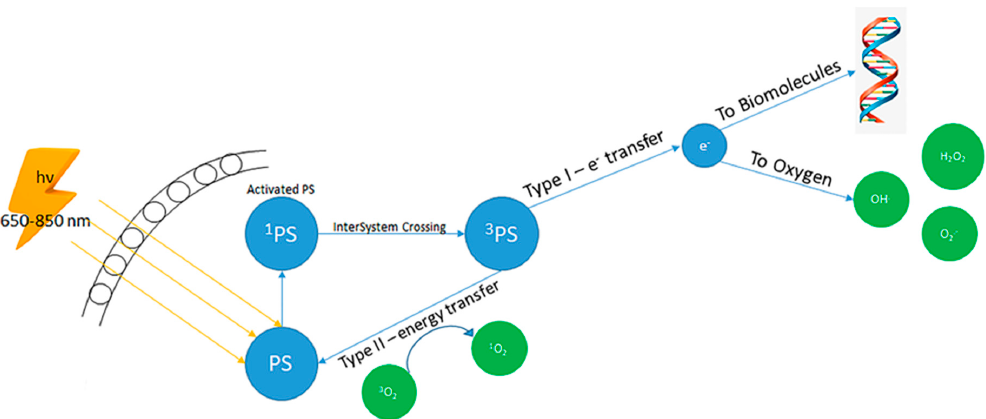
Figure 2. Mechanisms of photodynamic therapy. When a photosensitiser (PS) absorbs a photon, it is